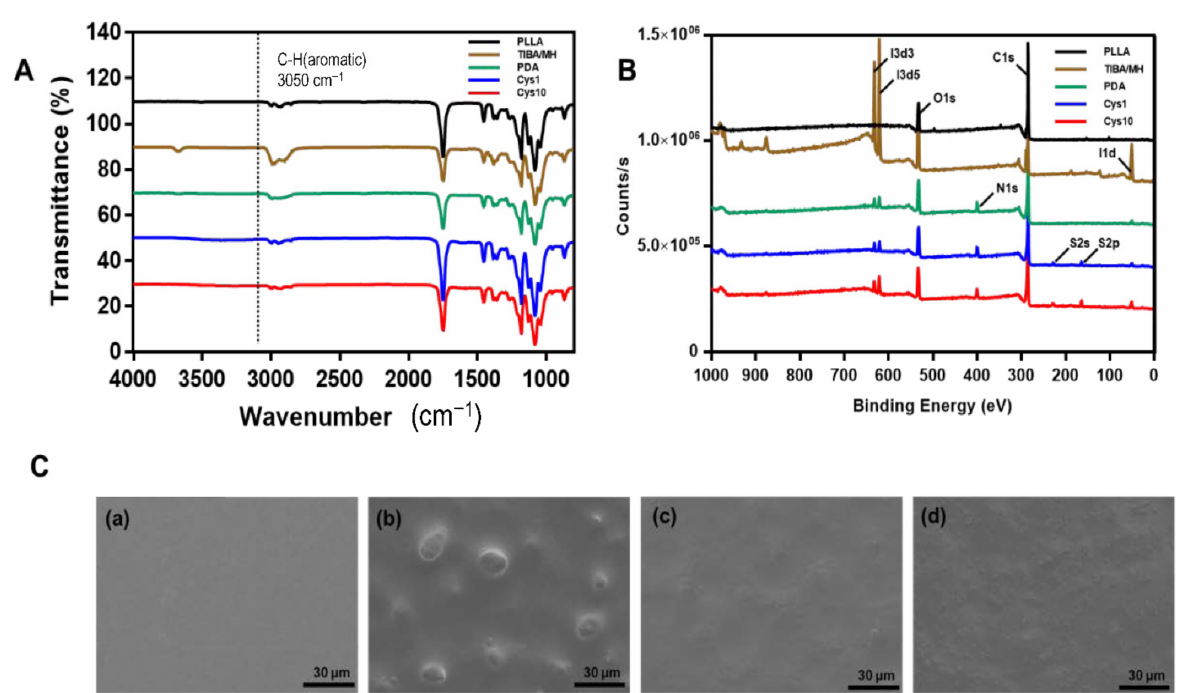
Figure 2. ( A ) ATR-FTIR spectra, ( B ) XPS spectra of of PLLA, TIBA/MH, PDA, Cys1, and Cys10, and ( C ) Surface morphology of ( a ) PLLA, ( b ) TIBA/MH, ( c ) PDLLA top coated TIBA/MH, and ( d ) PDA/Cys coated films (Scale bar = 30 µ